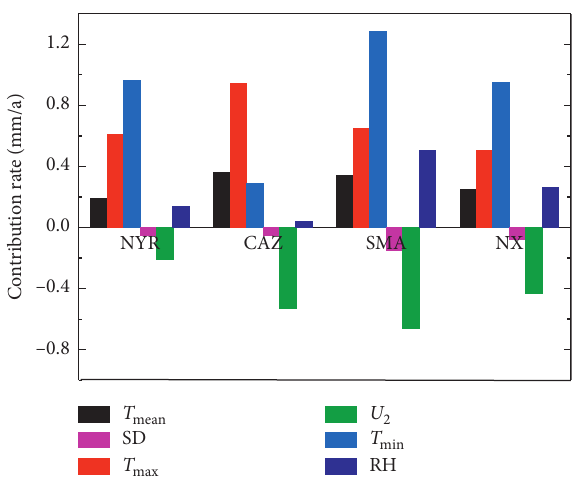
Figure 15: Contribution rate of the main climate factors in Ningxia at annual scale (mm/a). Table 8: Sensitive coefficient of the main climate factors to ET 0 from 1957 to 2018 in Ningxia at seasonal scale. Region Season